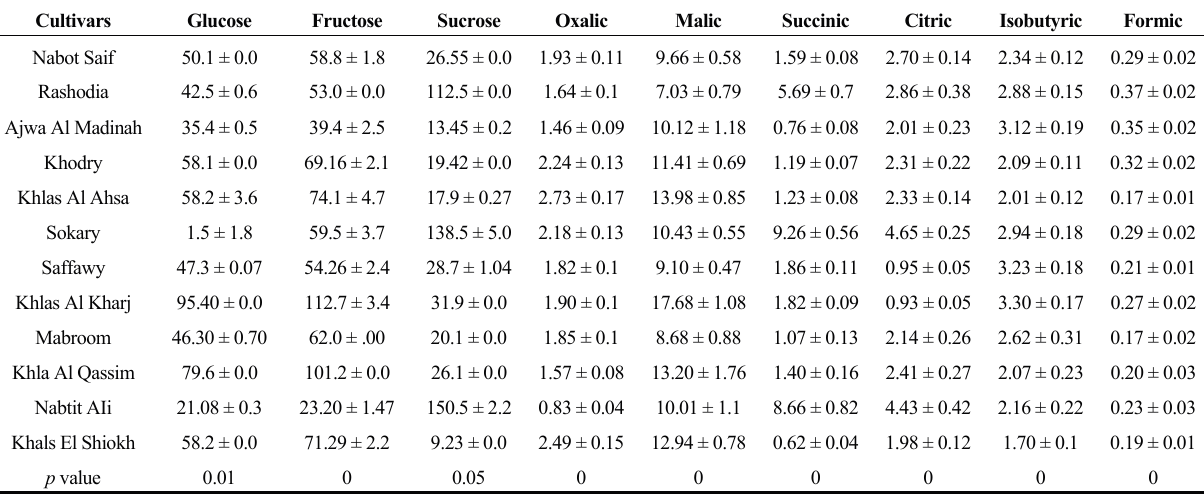
Table 3. Concentrations of sugars (mg/100 g FW) and organic acids (mg·g − 1 FW) in 12 Saudi date